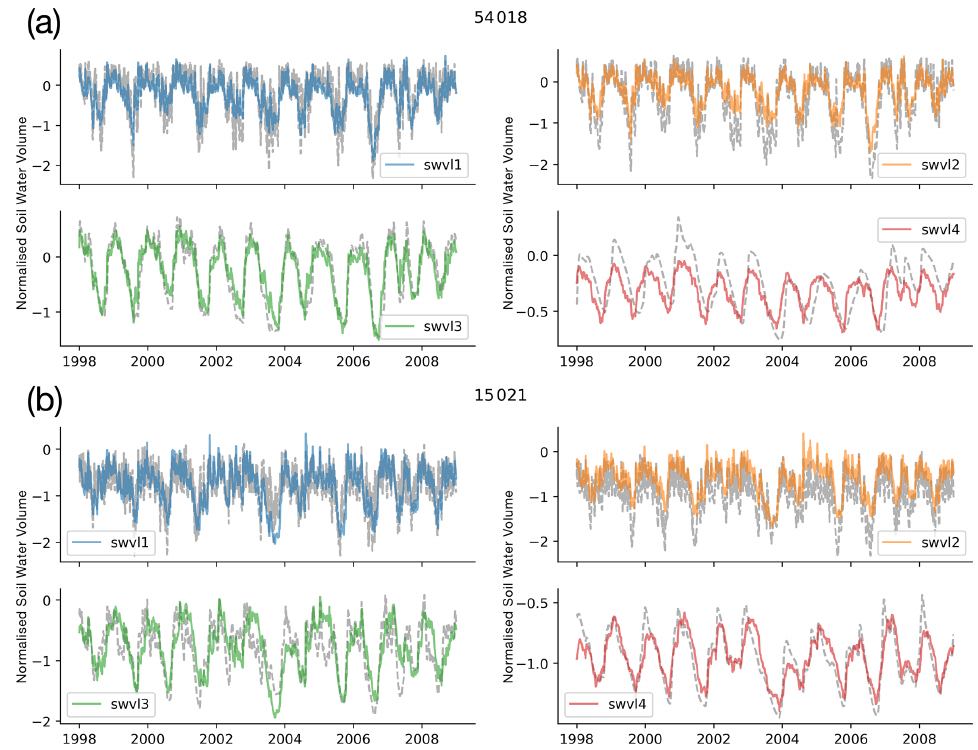
Figure C2. Time series of probe predictions with augmented inputs, including one-hot encodings of the gauge station ID (coloured lines) compared with the target variables (grey dotted lines). We show two catchments here, 52010, Rea Brook at Hookagate, and 15021, Burn at Burnham Overy. The results show that we learn a catchment-specific weight for adjusting the predictions and addressing the biases for each